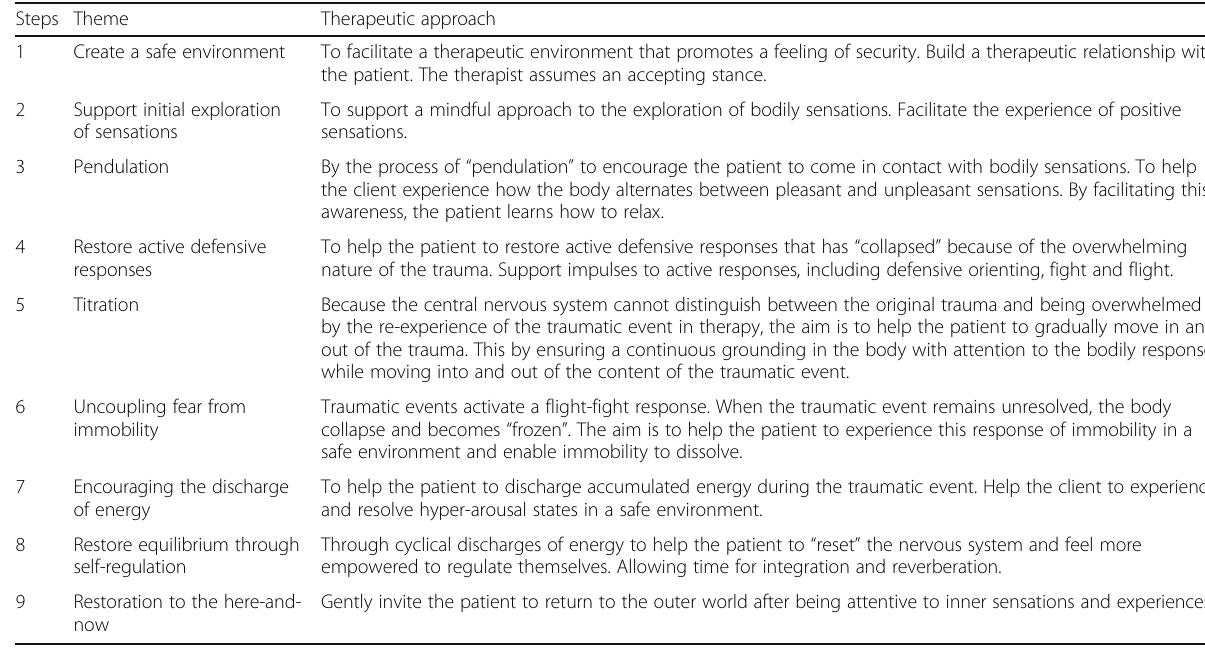
Table 1 Overview of the SE